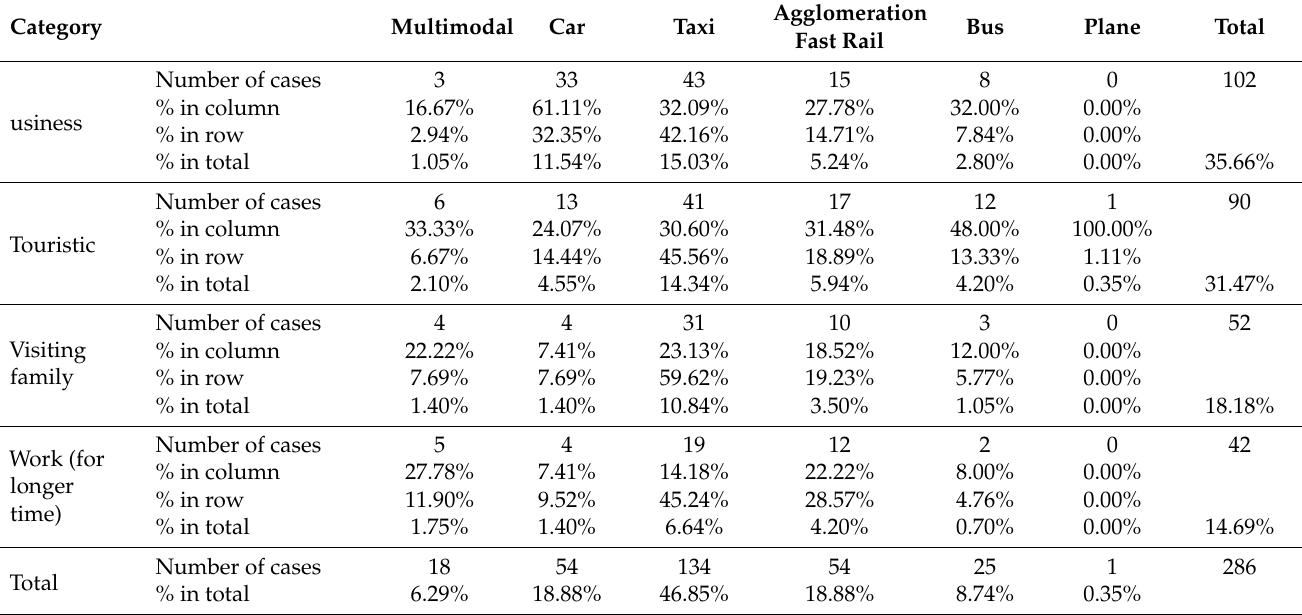
Table 4. Crosstable for purposes of the trip and chosen modes of